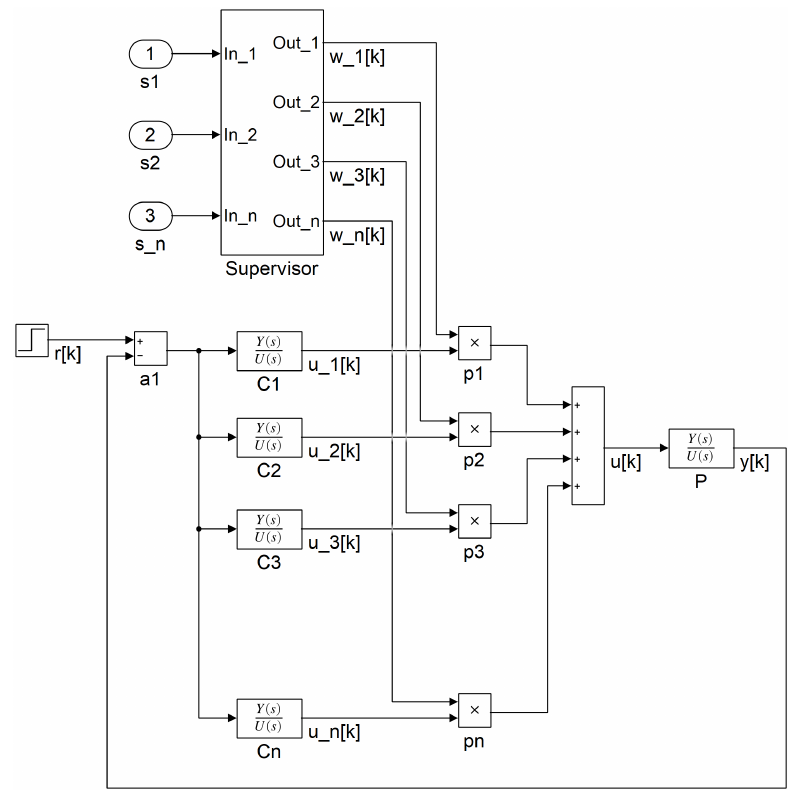
Figure 10. Multiple model controller schematic.